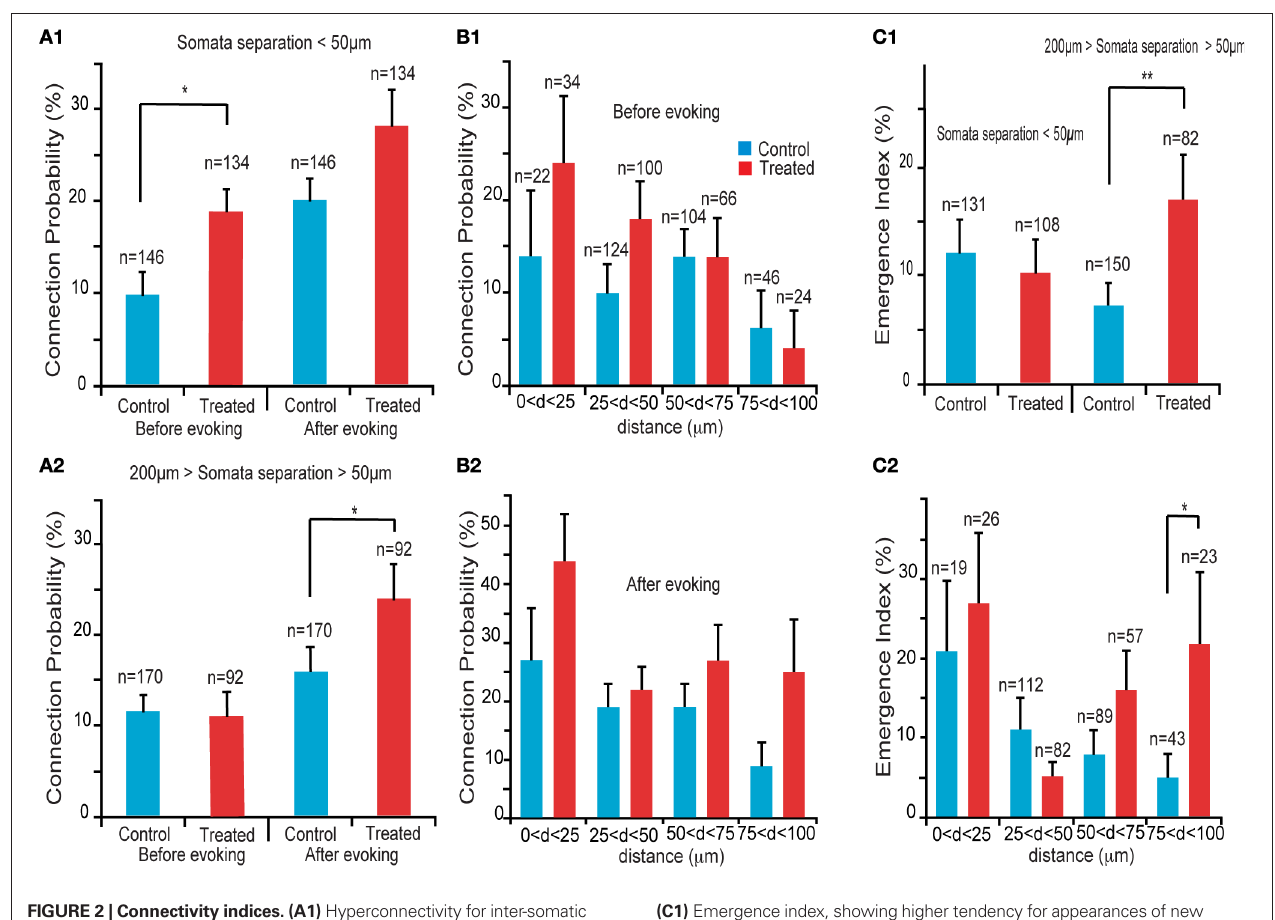
FIGURE 2 | Connectivity indices. (A1) Hyperconnectivity for inter-somatic distances smaller than 50 µm. (A2) Hyperplasticity for inter-somatic distances between 50 and 200 µm. (B1) Connection probability in (25 µm) discrete zones, before sodium glutamate perfusion. (B2) Connection probability in (25 µm) discrete zones, after sodium glutamate perfusion.